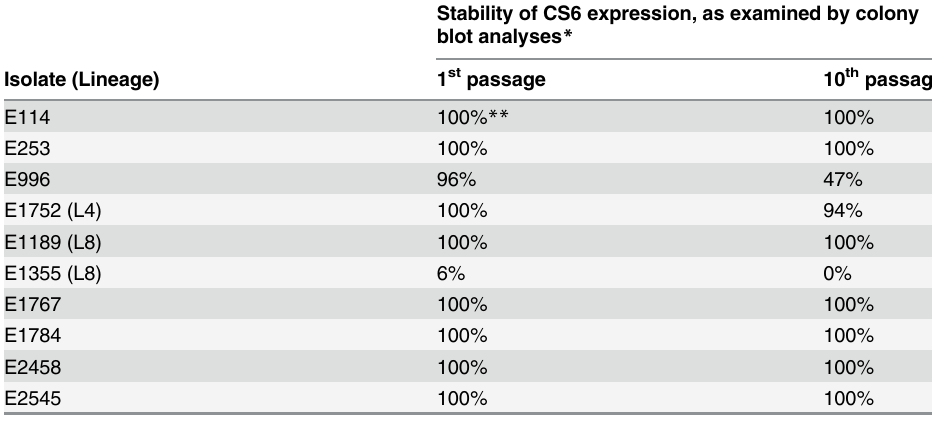
Table 4. CS6 phenotypic expression of CS6+STh ETEC isolates.